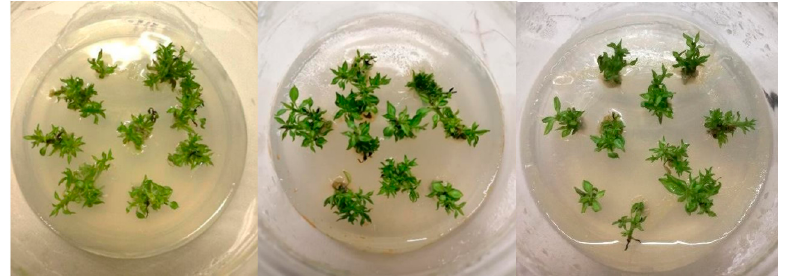
Figure 1. Overview of proliferated ‘Decana d’inverno’ shoots grown (from left to right) on substrate Control, ON 0.1 (with 0.1 mL L − 1 neem oil added) and ON 0.5 (with 0.5 mL L − 1 neem oil added).